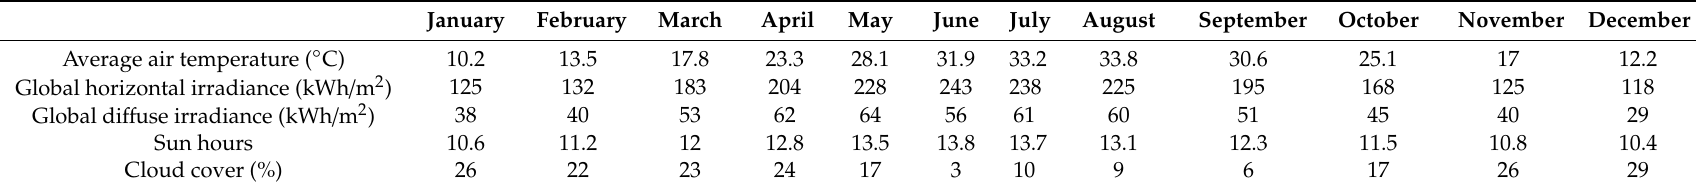
Table 4. Monthly climatic conditions of Ha’il